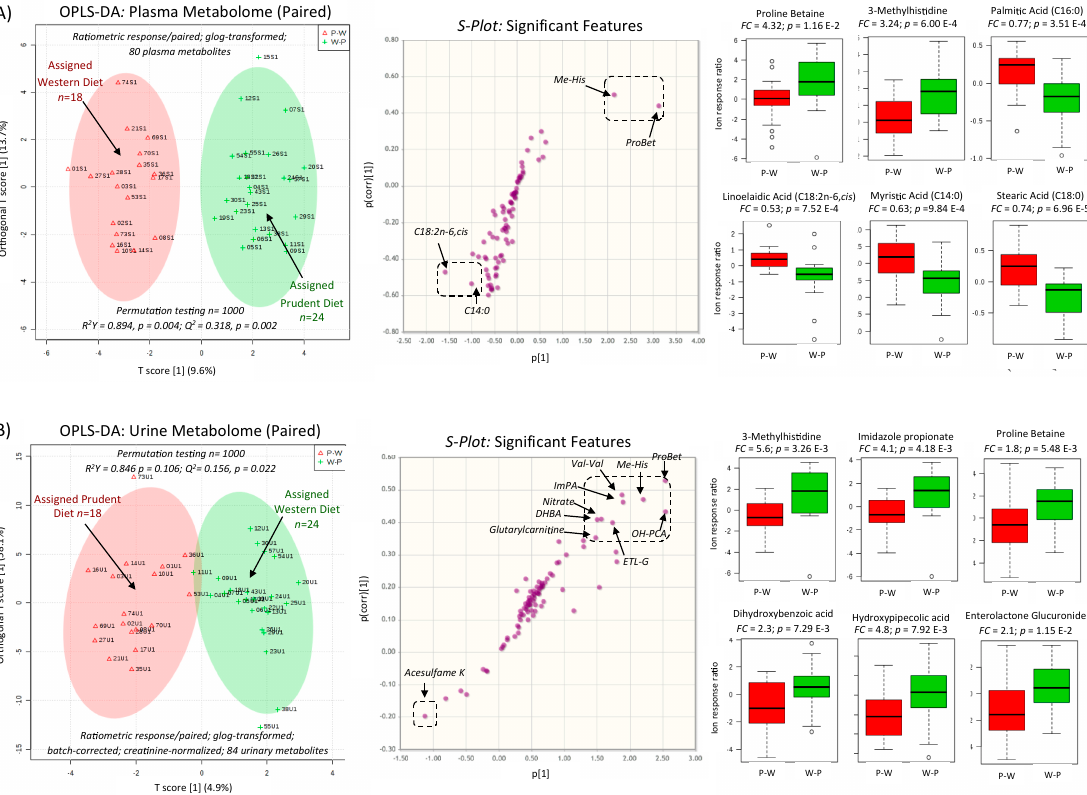
Figure 3. Paired supervised multivariate data analysis of ( A ) plasma and ( B ) creatinine-normalized urine metabolomic data using orthogonal partial least-squares-discriminant analysis (OPLS-DA) using the ratio of ion responses or concentrations for metabolites measured for each participant following two weeks of food provisions relative to their baseline habitual diet. 2D scores plot highlight di ff erences in the overall metabolic phenotype from matching plasma and urine specimens collected from DIGEST participants assigned a Prudent (W-P) or Western (P-W) diet. A sub-set of metabolites responsive to contrasting diets are classified in the S-plots, which were largely consistent with univariate statistical analysis as shown in box-whisker plots for top-ranked metabolites di ff erentially expressed between the two treatment arms ( p < 0.05).